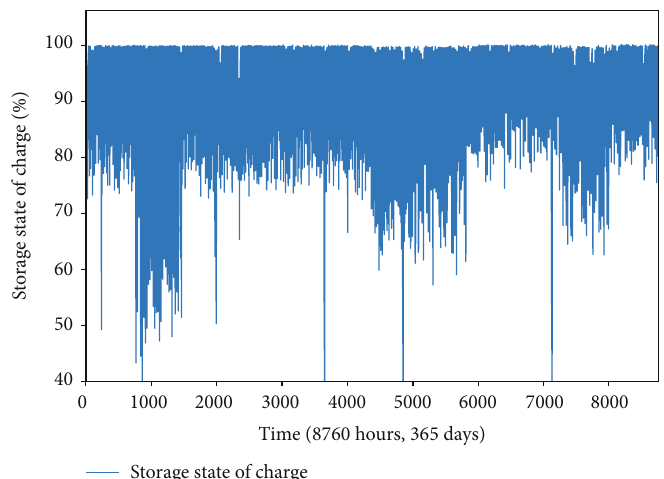
Figure 23: Storage input power for the unreliable grid model with the PV system solution.